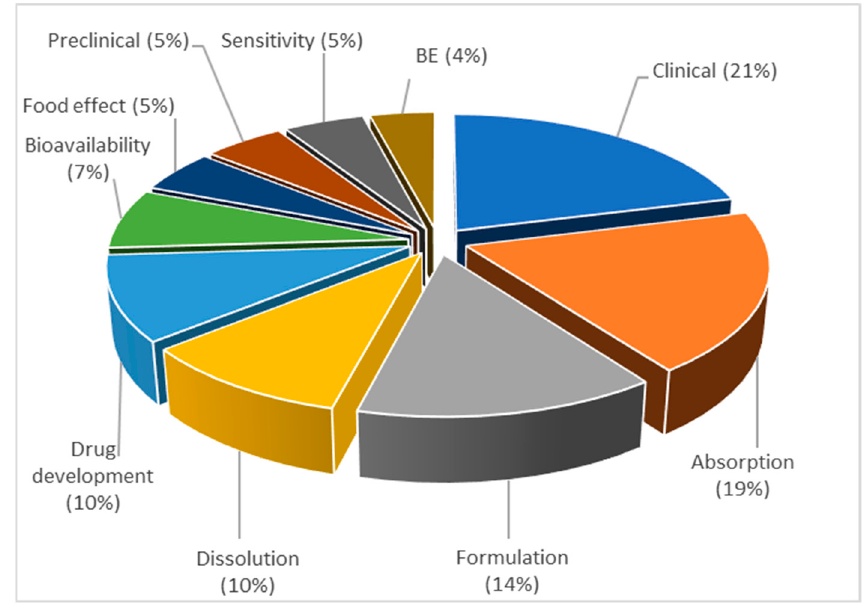
Figure 19. Distribution of published PBPK/PBBM models in relation to the application area within topic 5, expressed as frequency (%), normalized to 100%.